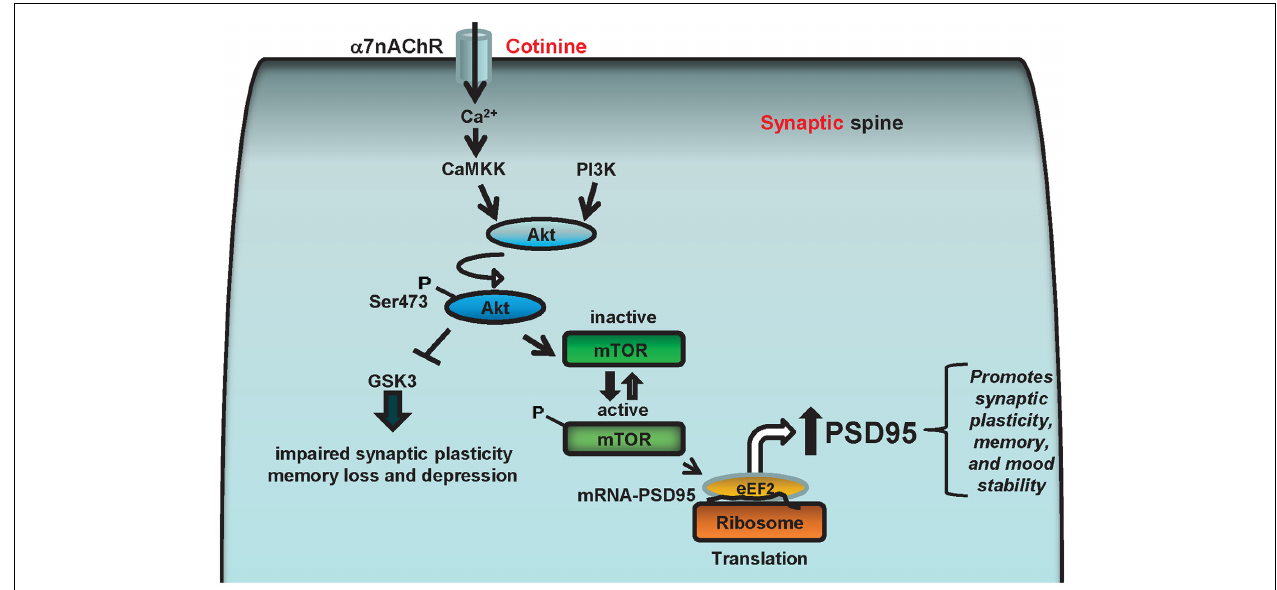
FIGURE 5 | Diagram representing the potential cell signaling pathways underlying the positive actions of cotinine on synaptic plasticity and behavior. The α 7nAChRs can stimulate Akt (aka, protein kinase B) through the calcium-dependent activation of CaMKK, which can activate Akt that in turn phosphorylates and stimulates CREB and/or the mammalian target of rapamycin (mTOR) activity. The α 7nAChR may also stimulate Akt through ERK/PI3K, and CREB and mTOR phosphorylation. mTOR, and CREB are